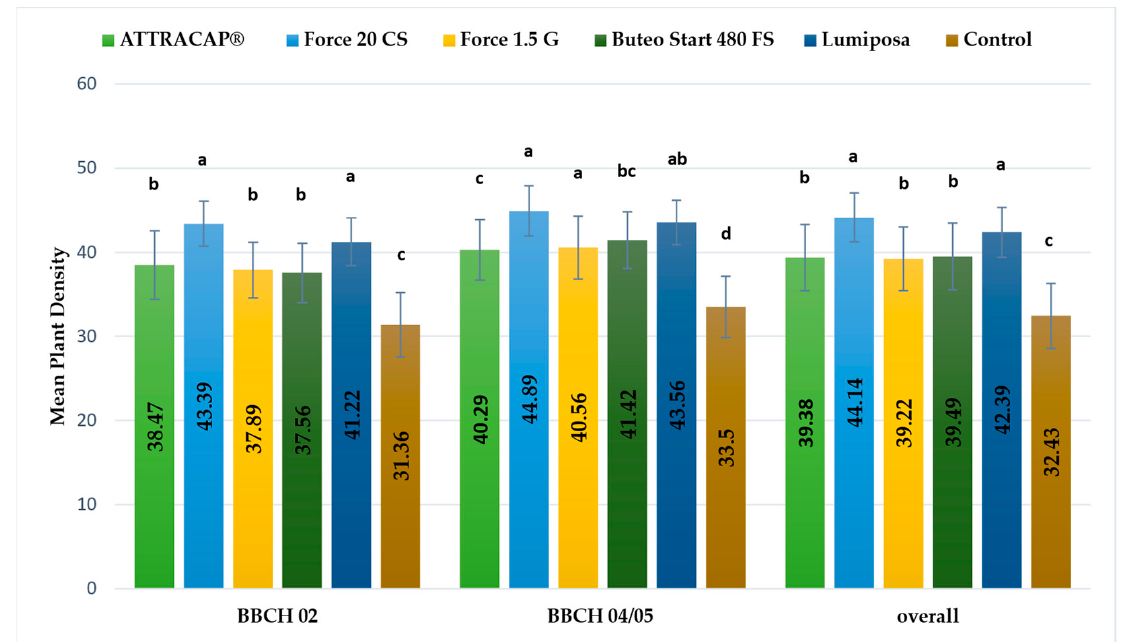
Figure 3. Plant density depending on the insecticidal treatment at RŠ Field 1 in 2021.